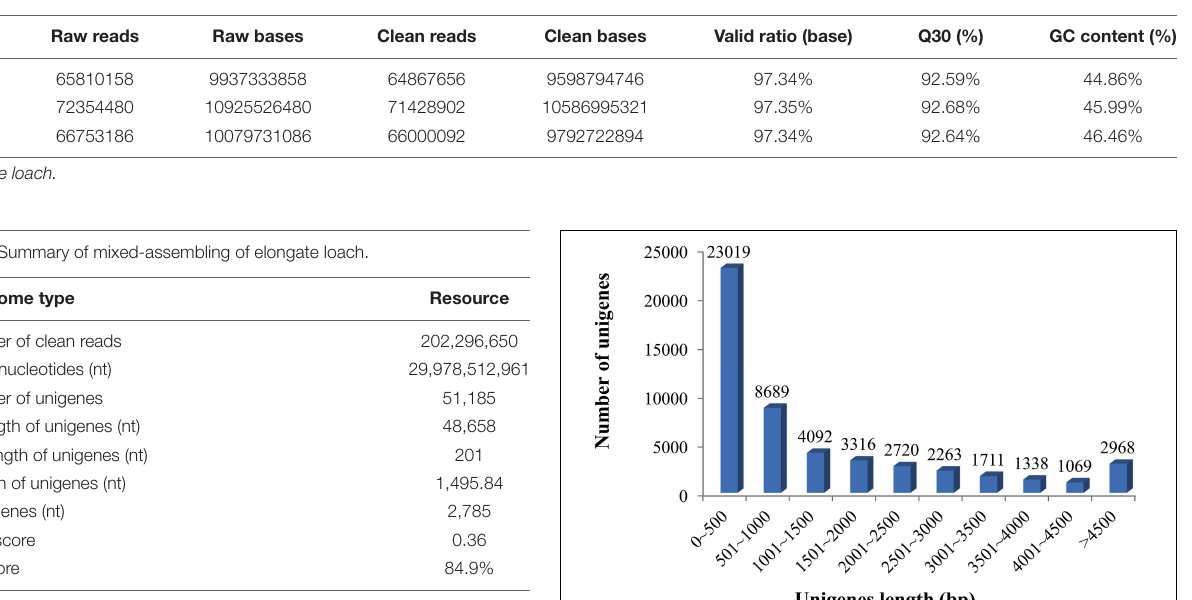
TABLE 1 | Sequencing details of each library for mixed-assembly in elongate loach.